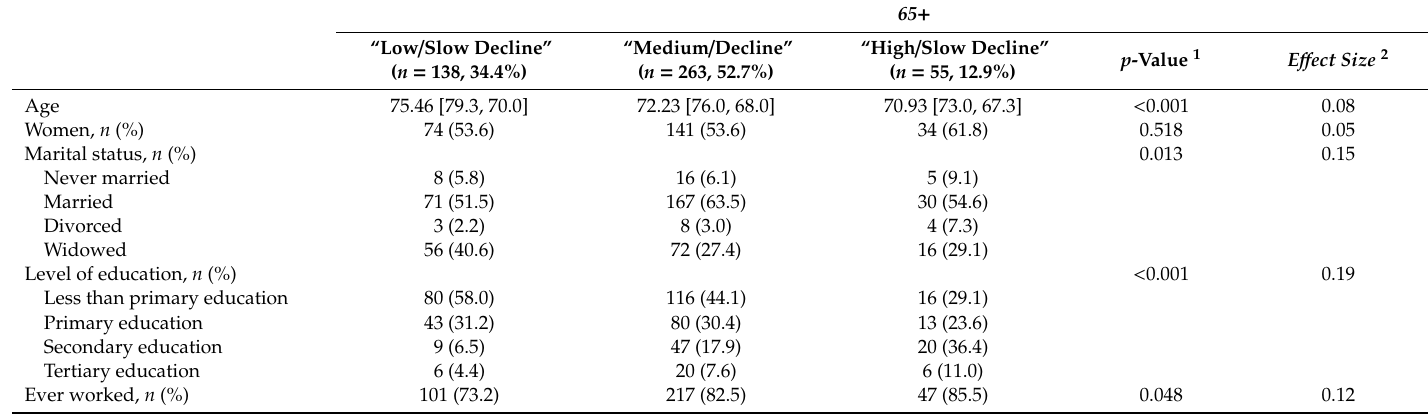
Table 6. Comparison of sociodemographic and clinical characteristics between delayed verbal memory trajectories in the 65 +